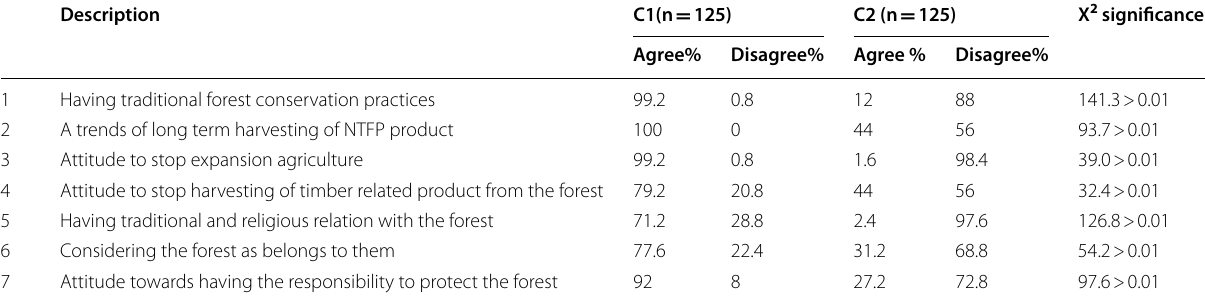
Table 6 Attitude proportion of the households (%) in for forest conservation stratified by household native category